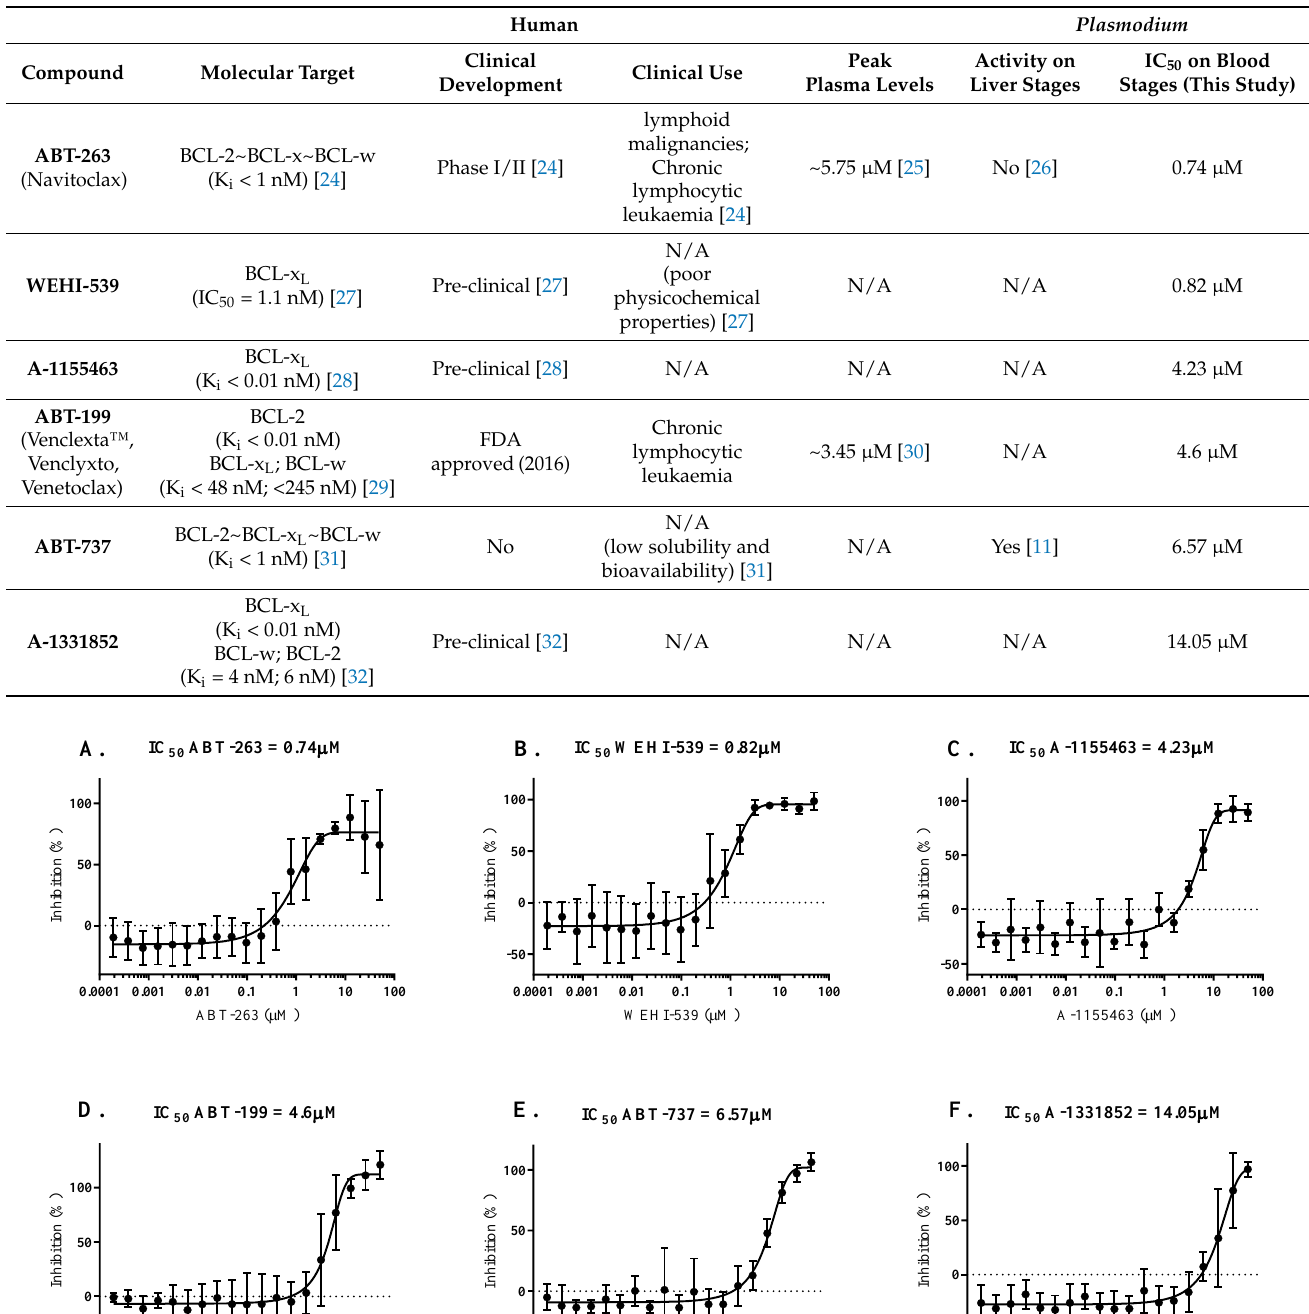
Table 1. BCL-x L inhibitors tested for inhibition of P. falciparum viability in this study. The com- pound’s molecular target(s), current phase of clinical development, and clinical purpose are indicated. The reported activity of the compounds on Plasmodium liver stages is reported when available. The IC 50 measured for each compound on P. falciparum blood stage in this study is reported (see Figure 1 for details). K i : inhibitory constant (reflective of the compound binding affinity).